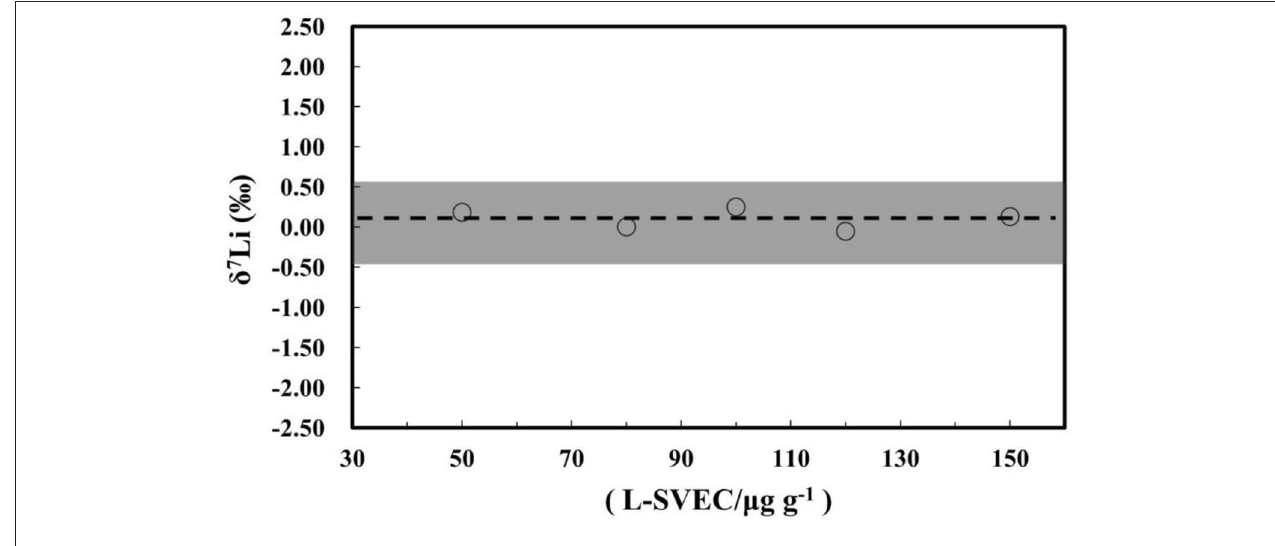
FIGURE 9 | Intensity effect on Li isotope measurements of L-SVEC.